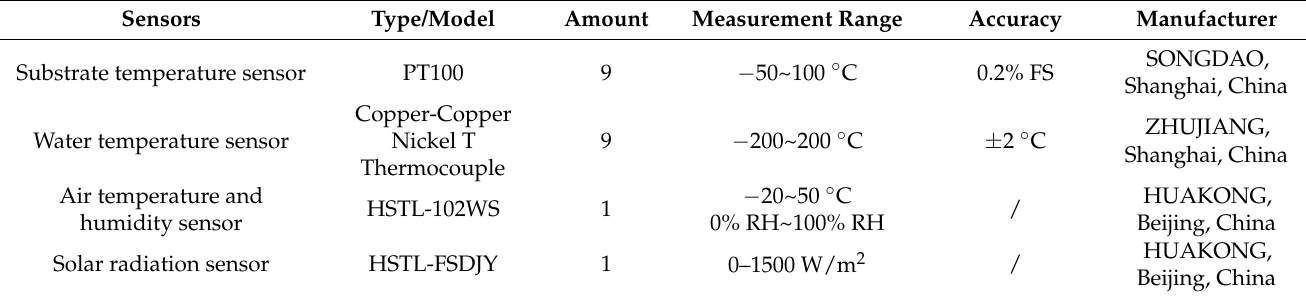
Table 1. Detail information of the sensors.